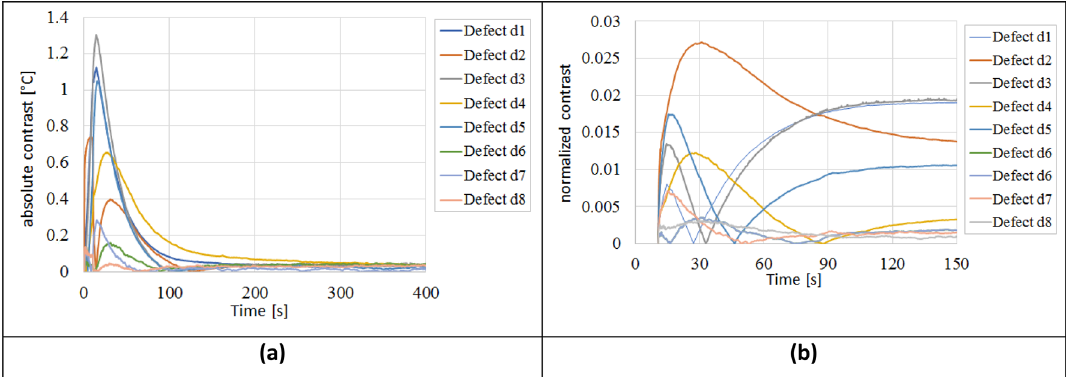
Fig. 13 Absolute contrast ( a ) and normalized contrast ( b ) for the traditional thermography (heating time 10 s)